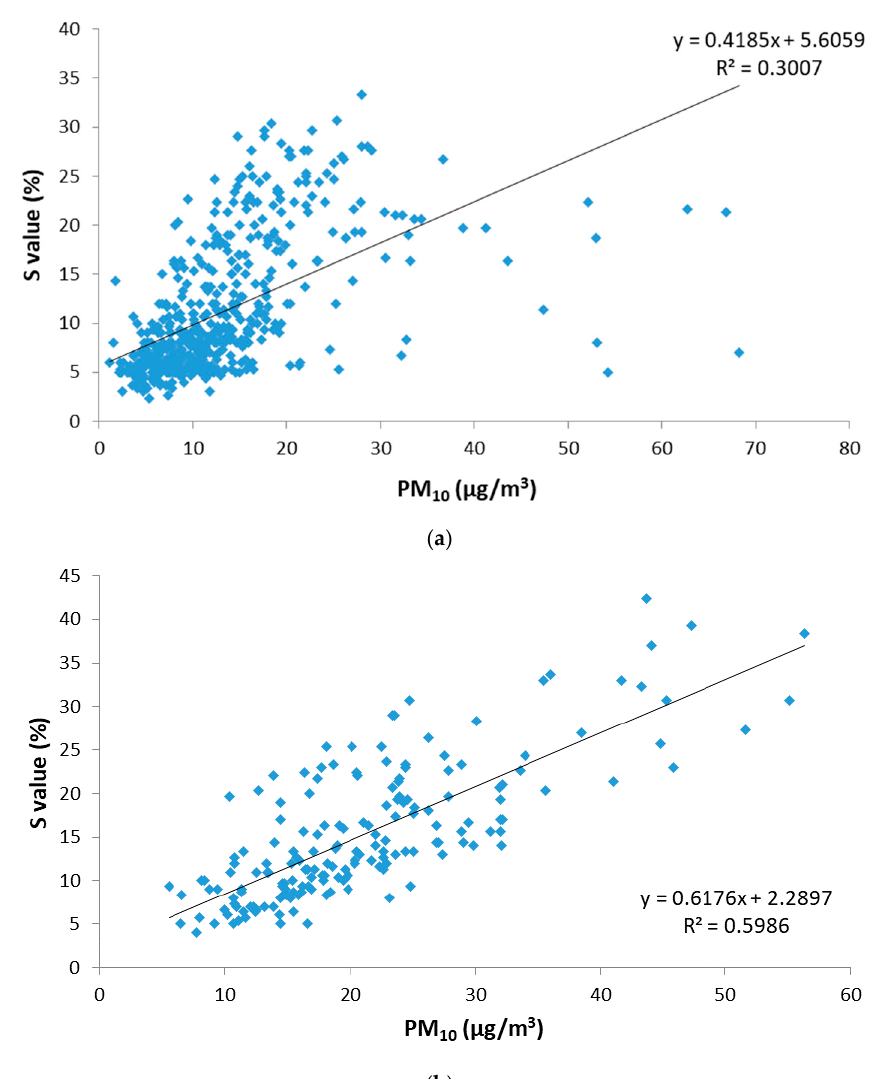
Figure 7. Relationship between saturation (S HSV ) and gravimetric PM 10 concentration for remote source influence during 2015 at Badajoz and Monfragüe. ( a ) No-SDO days and ( b ) SDO days. When regression analysis was performed, correlation parameters for the saturation (S HSV ) of SDO days improved the results obtained previously for the whole data set to R 2 = 0.599. Correlation